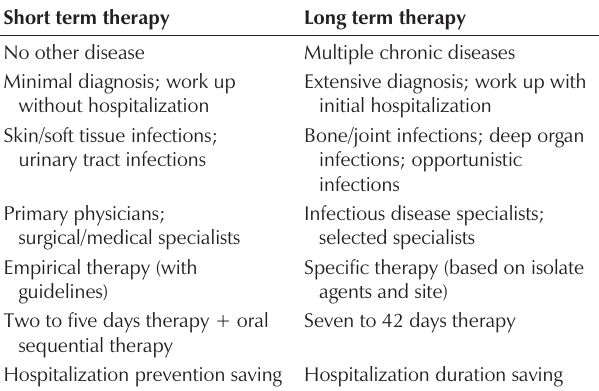
Extensive diagnosis; work up with initial hospitalization Bone/joint infections; deep organ infections; opportunistic infections Infectious disease specialists; selected specialists